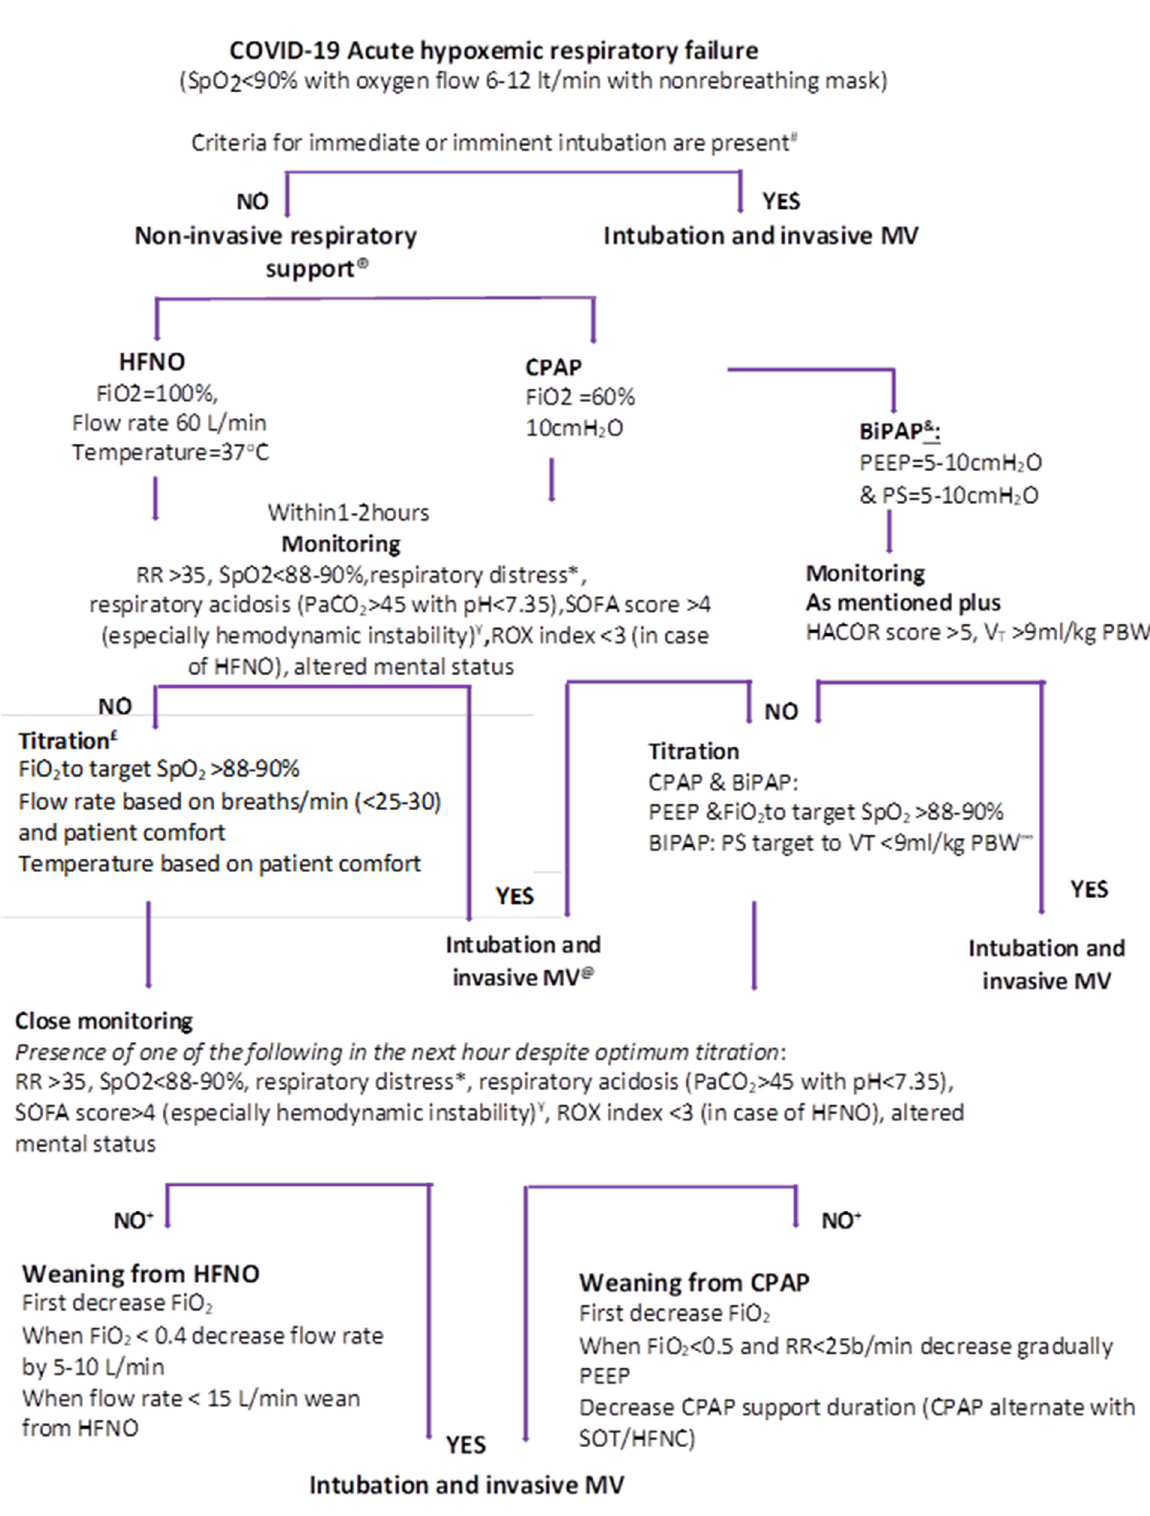
Figure 1. Recommended algorithm for noninvasive respiratory support in COVID-19 patients with acute hypoxemic respiratory failure. Patients with PaCO 2 > 45 mmHg are excluded. # Criteria for immediate or imminent intubation